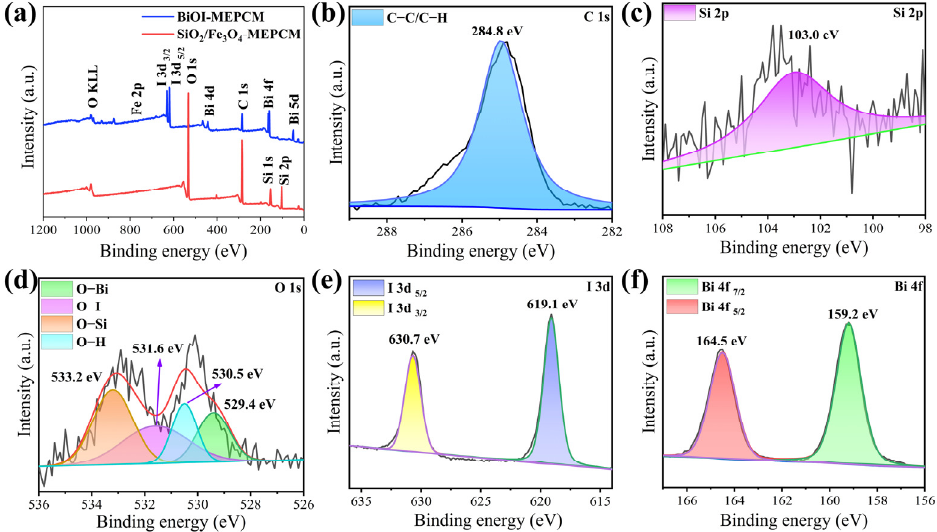
Figure 3. ( a ) Survey XPS spectra of phase-change microcapsules. ( b – f ) High-resolution XPS spectra of